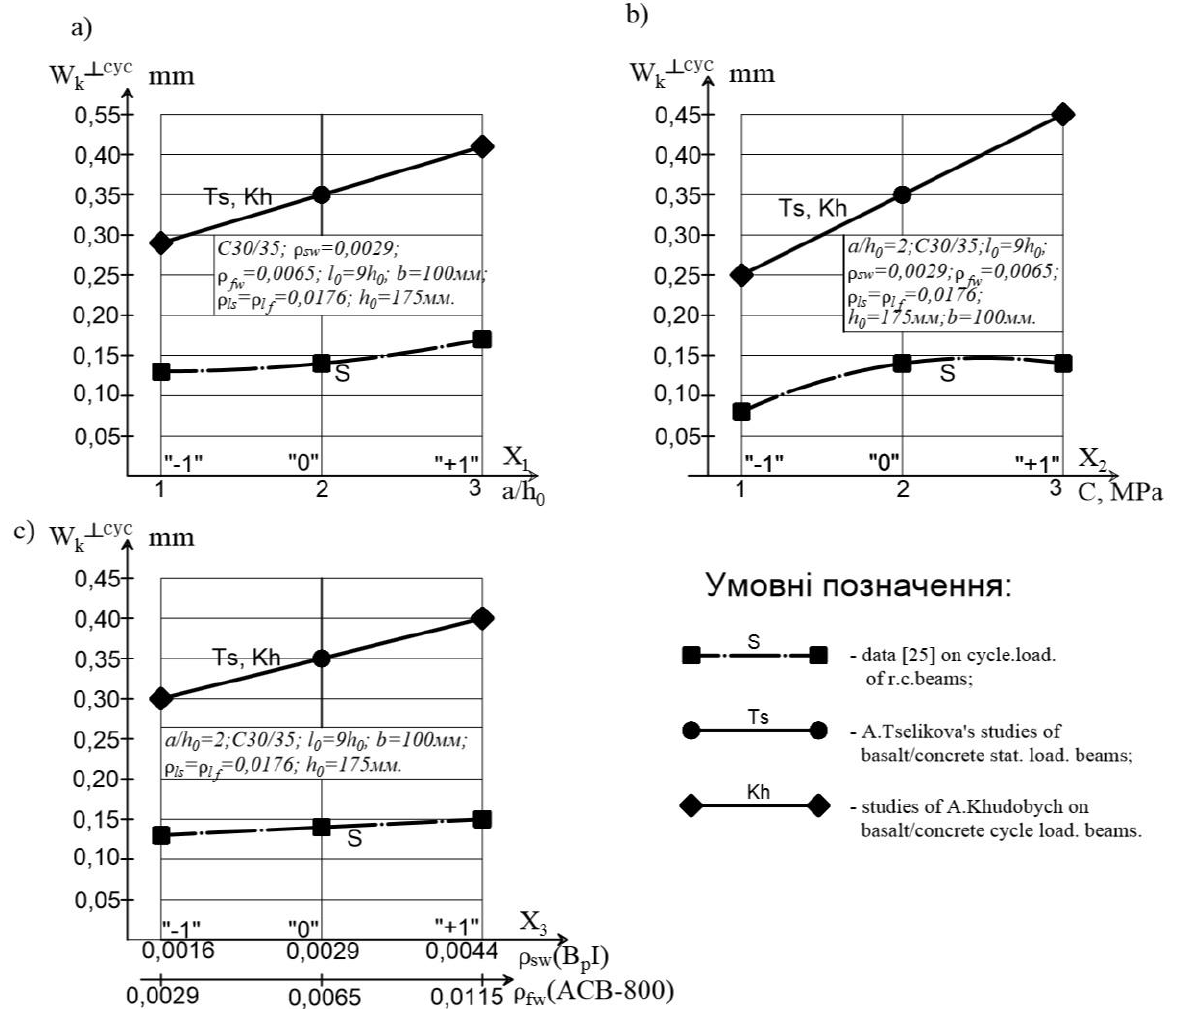
Figure 5. Impact of the design factors on the opening width of normal and inclined cracks in the tested reinforced concrete and BFRP concrete beams subjected to static low-cycle loading of the operational